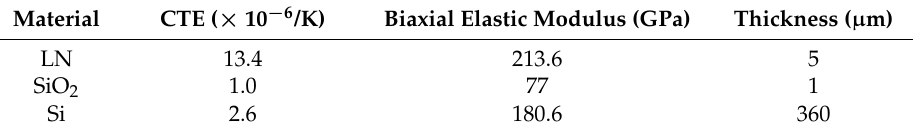
Table 1. Material parameters used in the calculation